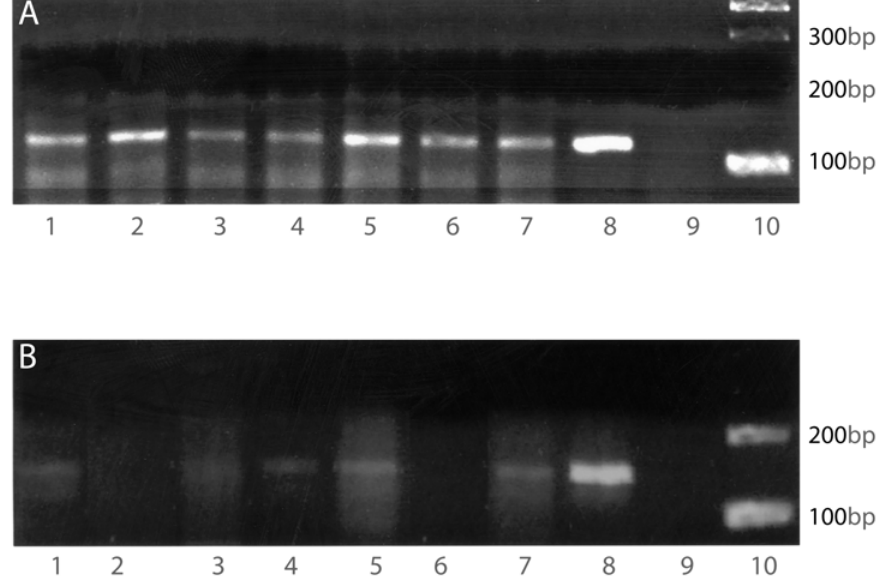
FIGURE 1- DNA detection by PCR. A: Detection of b-globin gene DNA. Lanes 1-7, samples from patients; lane 8, C33 cell DNA without HPV infection; lane 9, negative control (H O); lane 10, molecular marker (100 bp); B: Detection of HPV DNA in 2 samples from patients with OSCC. Lanes 1-7, samples from patients; lane 8, HeLa cell DNA infected with HPV 18; lane 9, negative control (H O); lane 10, molecular marker (100 pb) 2